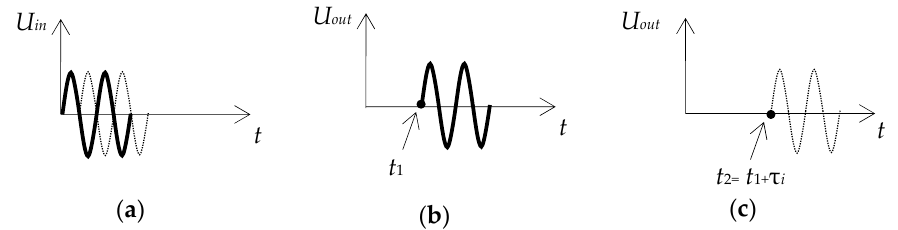
Figure 5. Pulse emission mode: ( a ) radiated pulse; ( b ) received pulse of quasi-longitudinal wave; ( c ) received pulse of quasi-transverse wave.